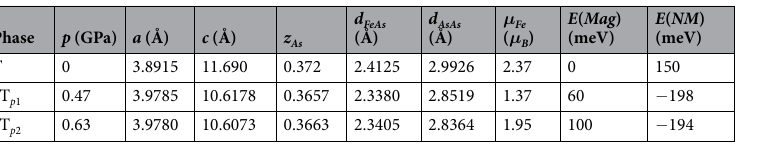
Table 1. The magnetic moment of Fe and ground state energy at various structural configuration of tetragonal CaFe 2 As 2 , the experimental lattice parameters are taken from ref.